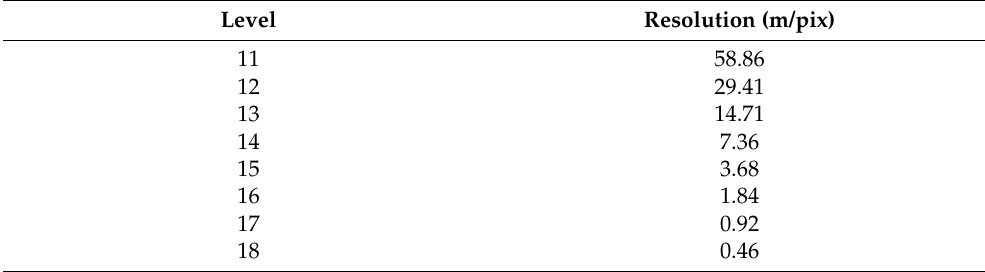
Table 3. Different levels of spatial resolution of the images used for classification.